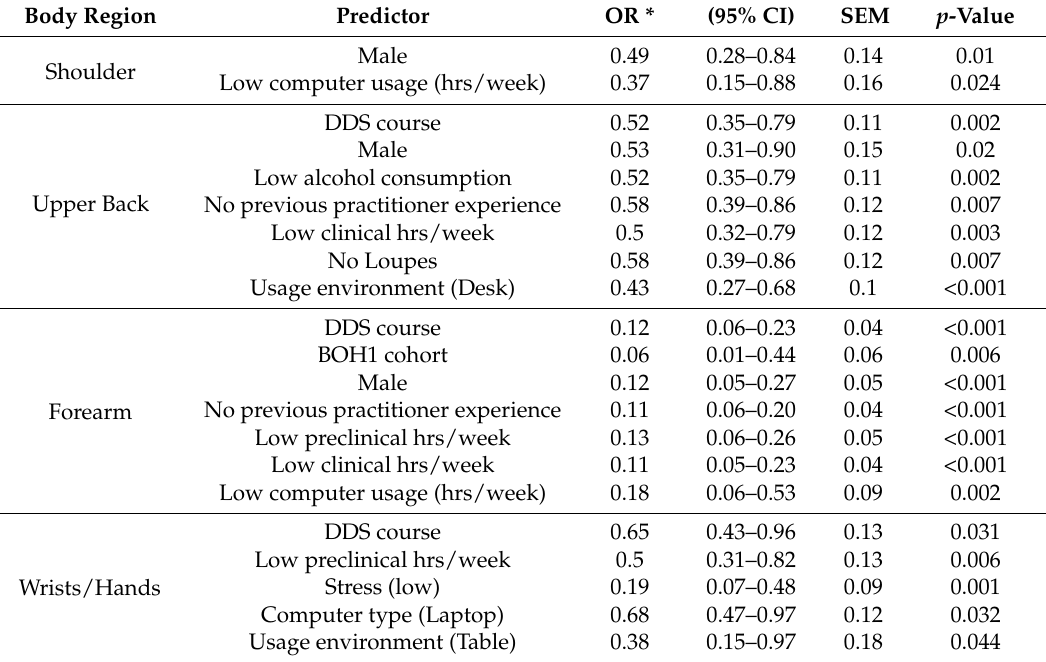
Table 7. Statistical correlates and predictors for non-reporting of